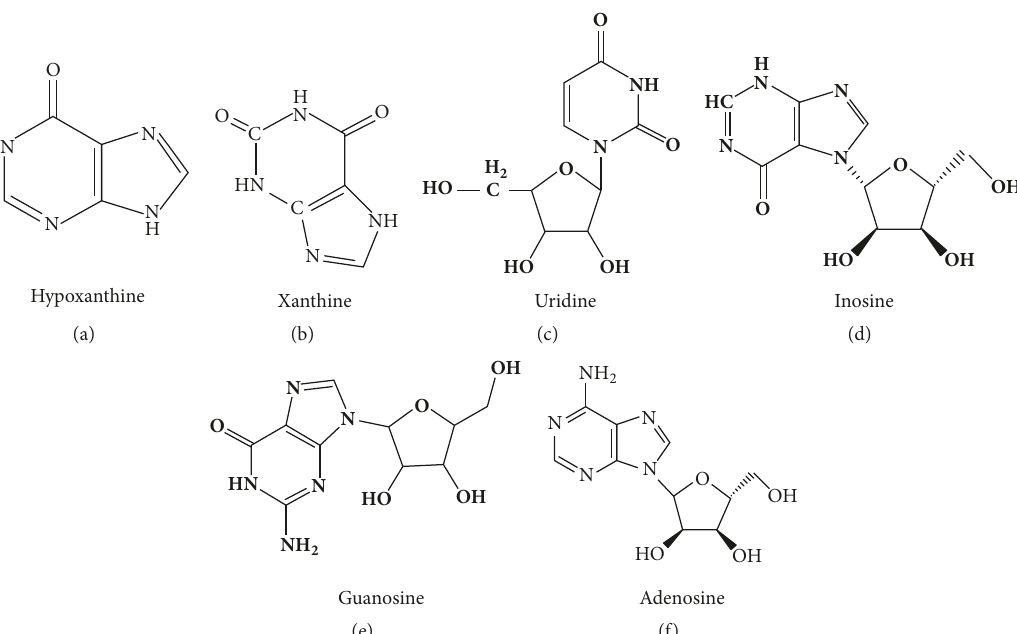
Figure 1: Chemical structures of the nucleoside reference components in Guang Dilong. Hypoxanthine (a), xanthine (b), uridine (c), inosine (d), guanosine (e), and adenosine